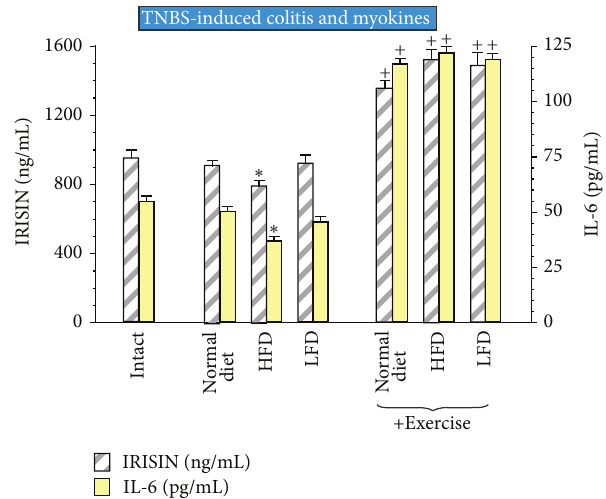
Figure7:TheeffectofexerciseontheplasmalevelsofirisinandIL-6 in trained and untrained rats fed normal diet, HFD, or LFD. Results are mean ± SEM of eight animals per each experimental group. Asterisk indicates a significant change ( 𝑃 < 0.05 ) as compared with respective values in intact rats. Cross indicates a significant change ( 𝑃 < 0.05 ) as compared with those obtained in animals not sub- jected to